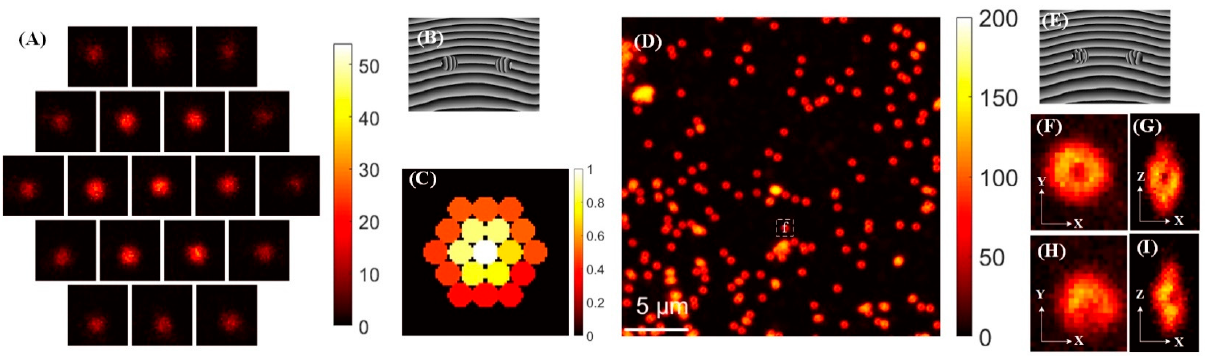
Figure 5 . The calibration process of the system by imaging 200 nm nanoparticles. ( A ) The images from each detector for a single nanoparticle at the focal plane. ( B ) The solid focus pattern. ( C ) The normalization energy distribution of detector array. ( D ) The negative focus image at the focal plane. ( E ) The 3D negative focus pattern. (F) The local enlarge image of the single nanoparticle indicated in the dash frame of ( D ). ( G ) The cross-section along the z axis of the same nanoparticle depicted in ( F ). ( H , I ) are the images before Zernike correction corresponding to ( F , G ).